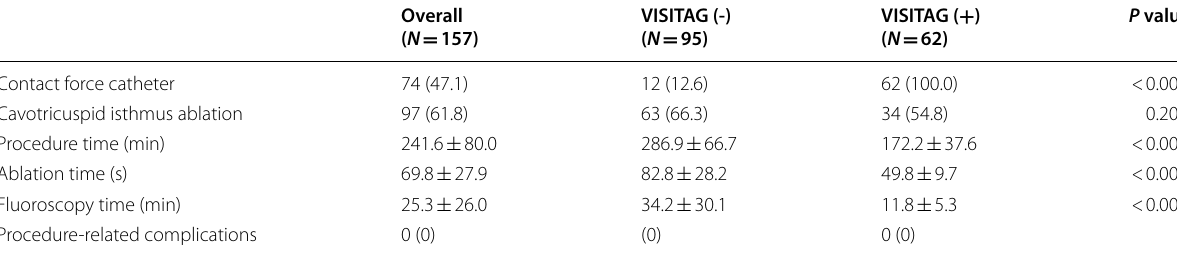
Table 2 Procedural characteristics